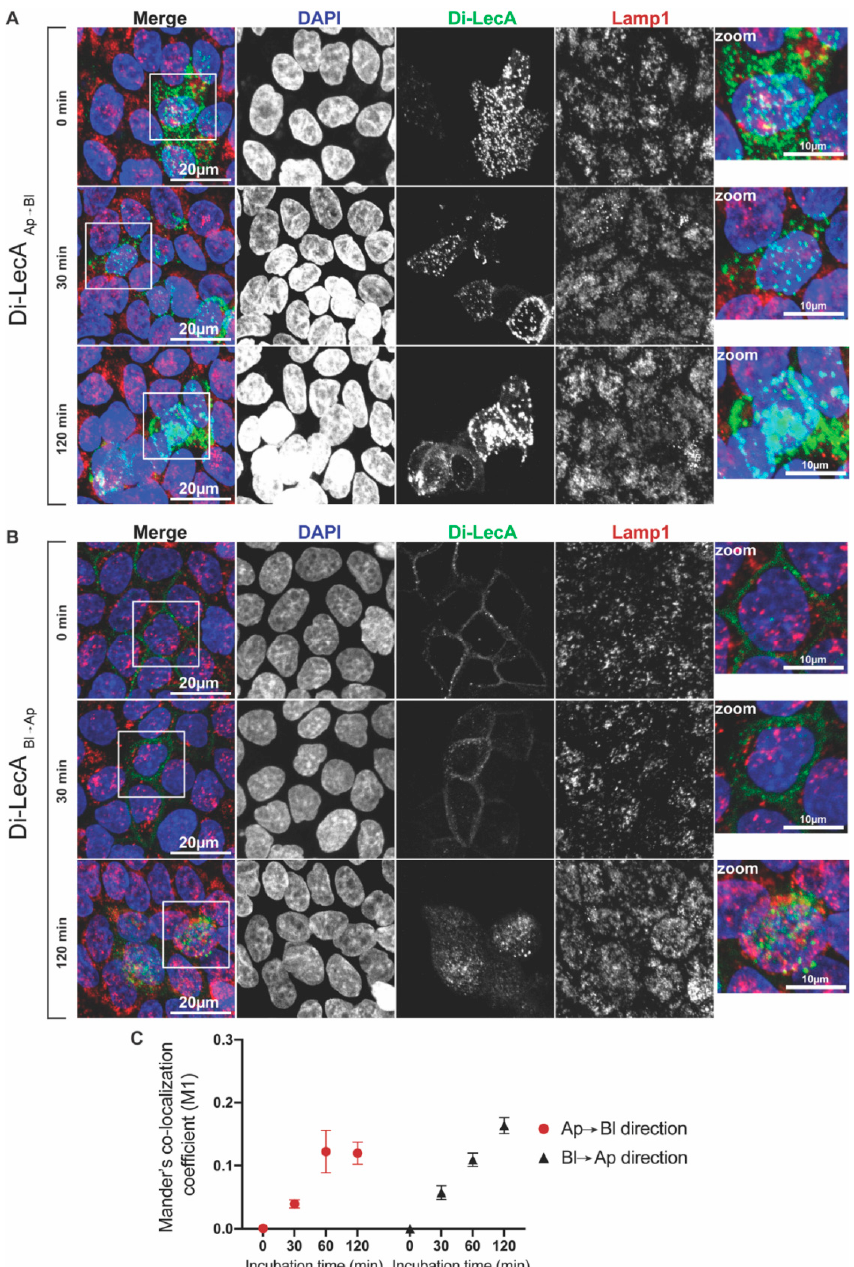
Figure 3. Co-localization analysis of Di-LecA with lysosomes. ( A ) Fluorescent Di-LecA (green) was pre-bound to the Ap cell surface of Gb3-positive MDCK cells at 4 °C for 30 min. After removing the excess unbound lectin, cells were shifted to 37 °C, allowing trafficking processes from the Ap to Bl membrane. After the fixation and permeabilization of cells, nuclei were stained with DAPI (blue), and Lamp1 was stained with a primary antibody, followed by incubation with the corresponding secondary antibody (red). Images were acquired via confocal microscopy, and representative maximum intensity projections are presented (scale bar: 20 µm; scale bar in the zoom: 10 µm). ( B ) Fluorescent Di-LecA was pre-bound to the Bl cell surface and intracellular trafficking from Bl to the Ap side through lysosomes was analyzed. Similar experimental conditions were applied as described in ( A ). ( C ) Mander’s M1 co-localization coefficient between Di-LecA and Lamp1 was calculated via the Coloc-2 plugin in ImageJ for different time points (0–120 min) of transport in the Ap → Bl and Bl → Ap directions. For each time point, the included individual cell number n was greater or equal to 30. The error bars represent the